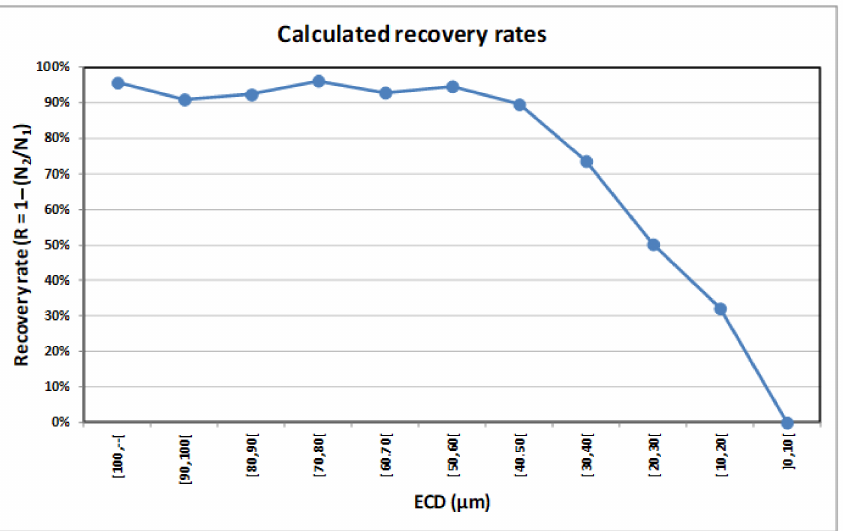
Figure 6. Recovery rates of gold grain with the fluidized bed according to the grain size, as obtained from the reprocessing of samples during a recent QAQC protocol. The recovery rate starts declining to below 40 µ m, collapses for grains smaller than 20 µ m, and fades almost to zero below 10 µ m. The calculations are based on 2528 grains from 43 samples processed over an 8-month